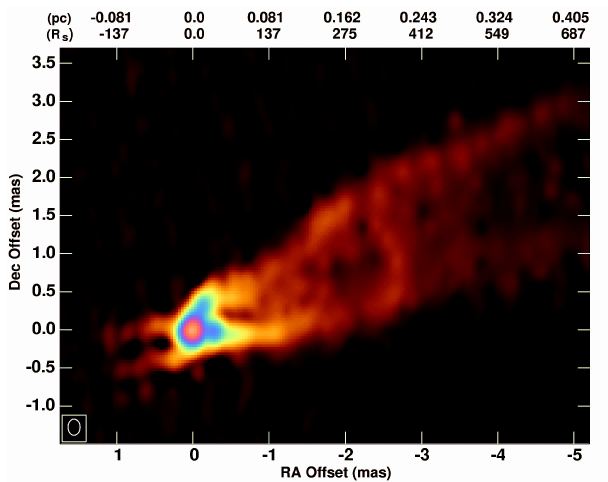
Figure 2. M87 43 GHz radio image of the inner region, including dominant and counterpropagating jets. Note 1 pc ≈ 12.5 mas. Image courtesy of Craig